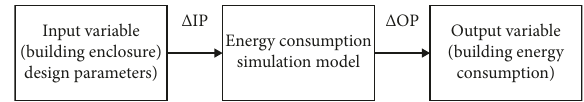
Figure 2: Principle of the energy-saving sensitivity analysis for the design parameters of the building